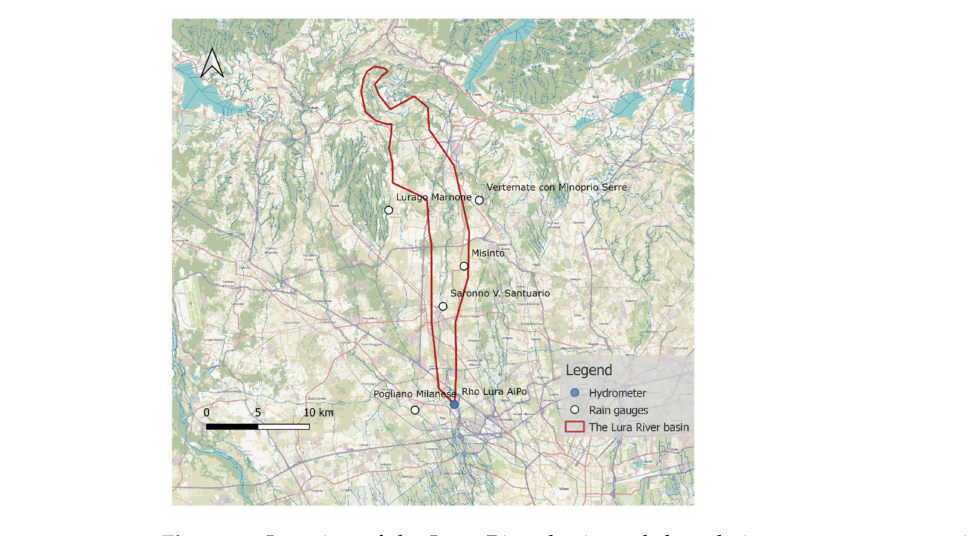
Figure 2. Location of the Lura River basin and the relative measurement stations. Map data © OpenStreetMap.